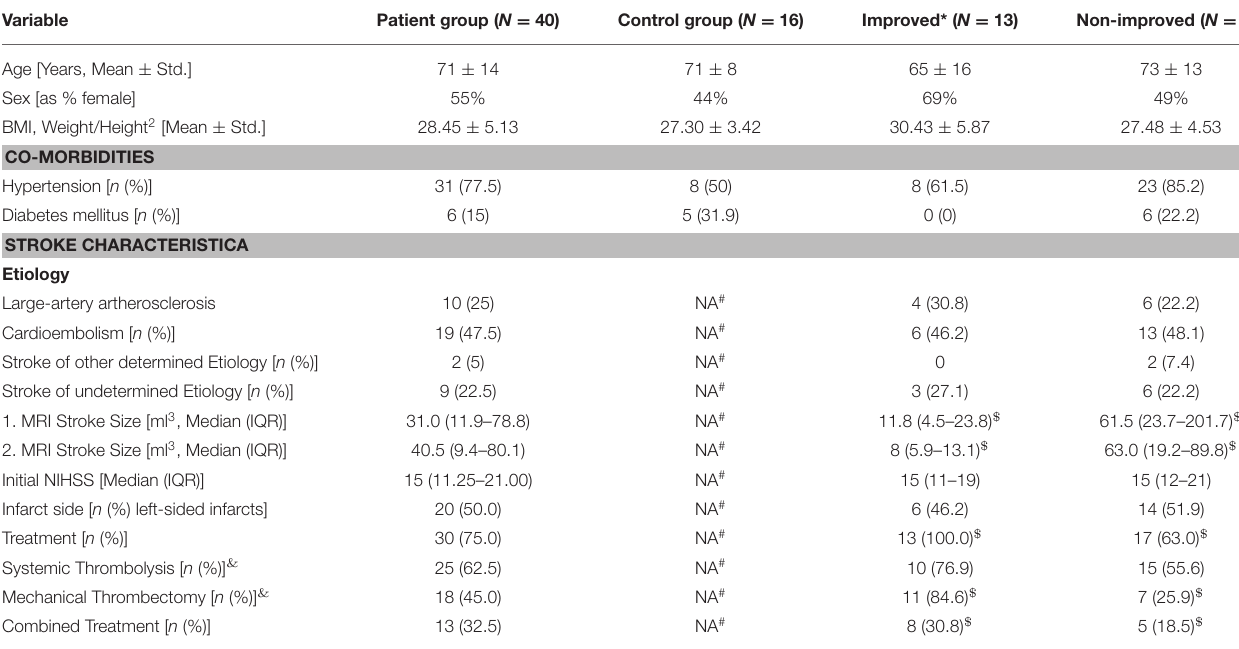
TABLE 1 | Patients